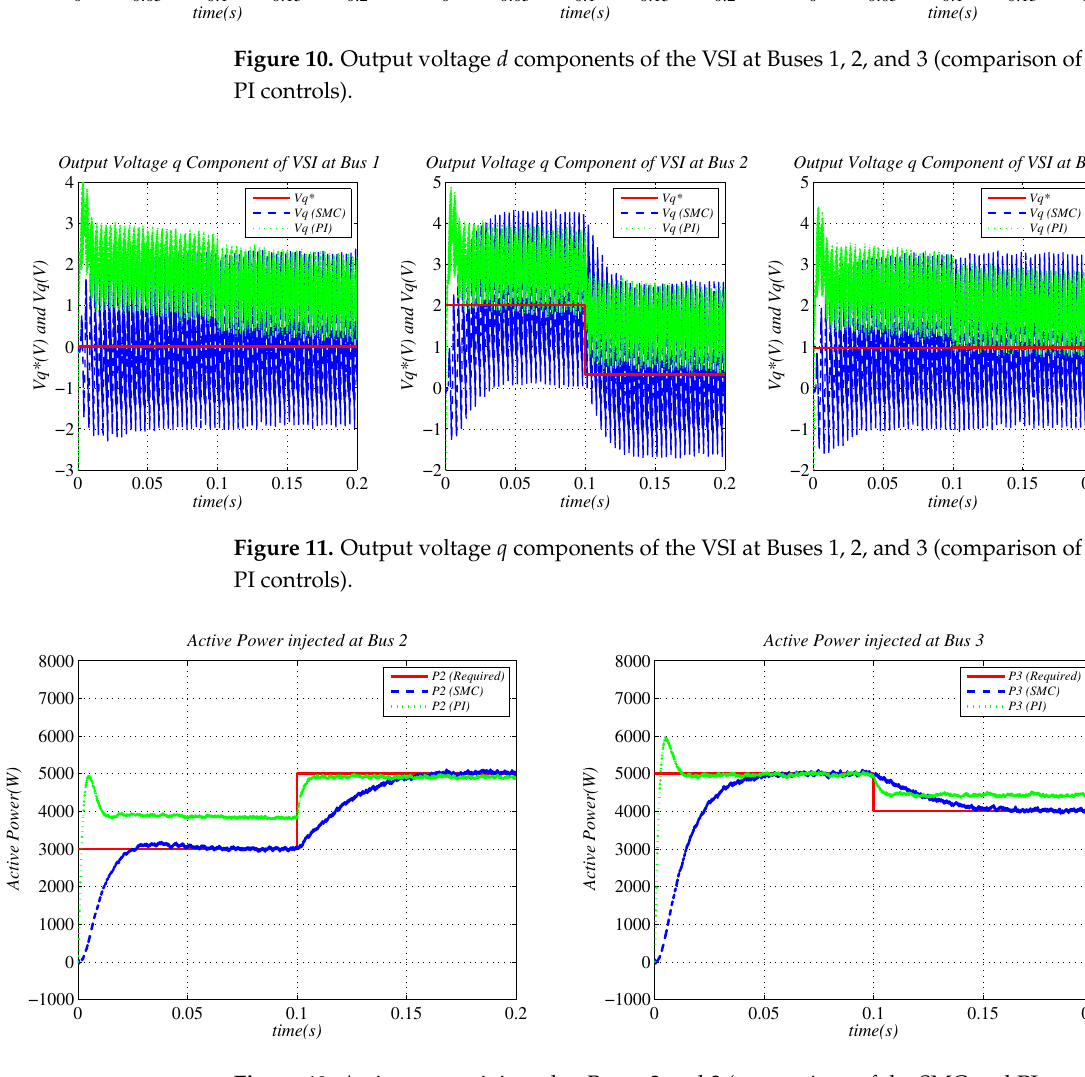
Figure 12. Active power injected at Buses 2 and 3 (comparison of the SMC and PI controls). To check the performance of the presented controller design with the presence of the nonlinear load, a thyristor-based fully controlled bridge rectifier with a 1 k Ω resistance was attached on Buses 1, 2, and 3 as shown in Figure 14. The simulation results show that the error was ultimately bounded in the dq reference frame and the scheduled power-sharing was